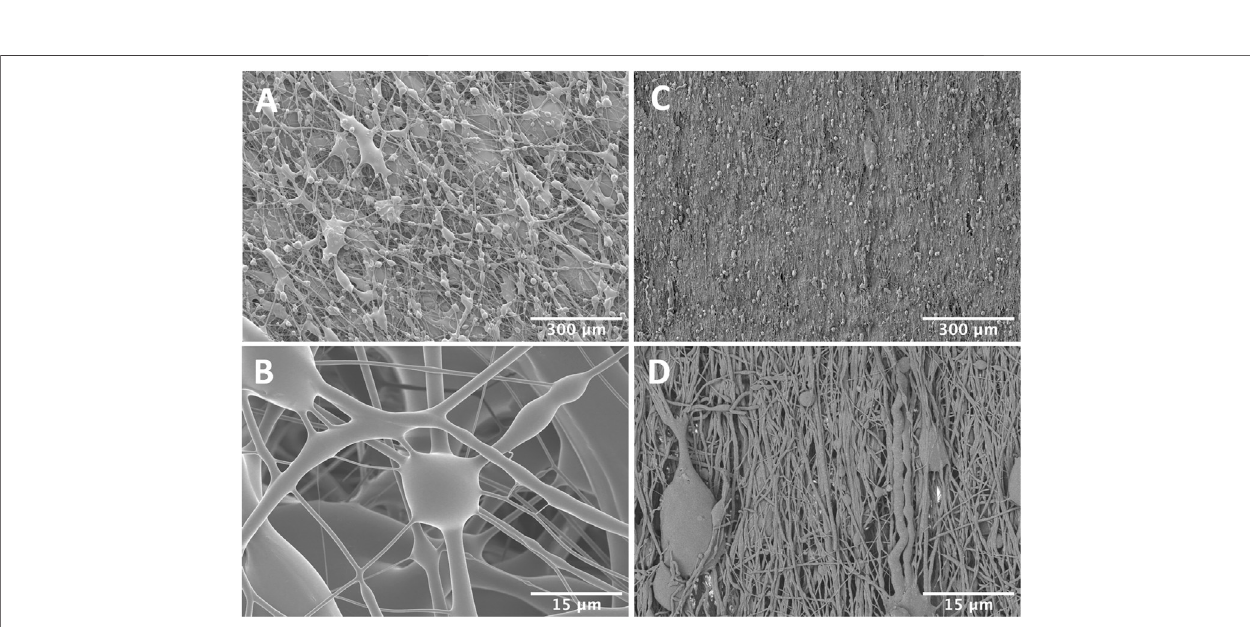
FIGURE 3 | Scanning electron micrographs of pneumatospun (A,B) or electrospun (C,D) collagen scaffolds after glutaraldehyde crosslinking. Note the larger interconnected porosities in the pneumatospun scaffolds.